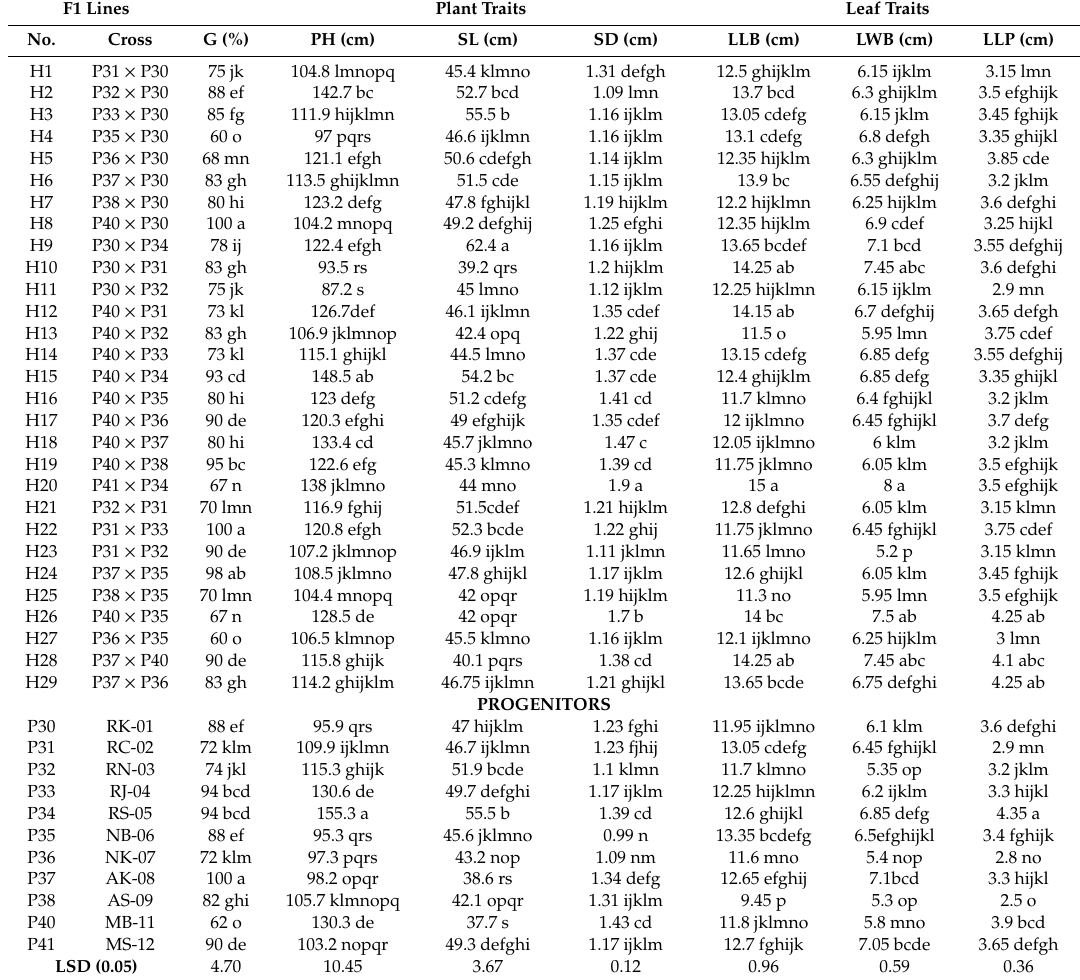
Table 5. Variation in the morphoagronomic traits evaluated in F1 lines and progenitors of habanero pepper. Plant Traits Leaf